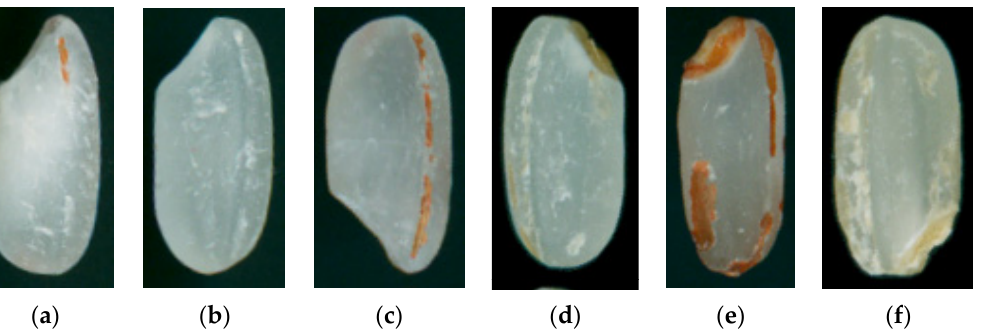
Figure 2. Single-grain rice images of three kinds of DOM. ( a , b ) Well-milled. ( c , d ) Reasonably well-milled. ( e , f ) Substandard.